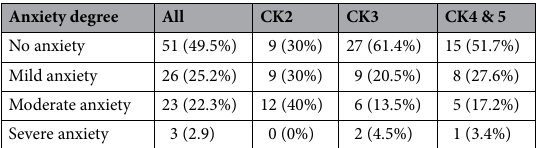
Table 3. Degree of Anxiety according to CKD stage.